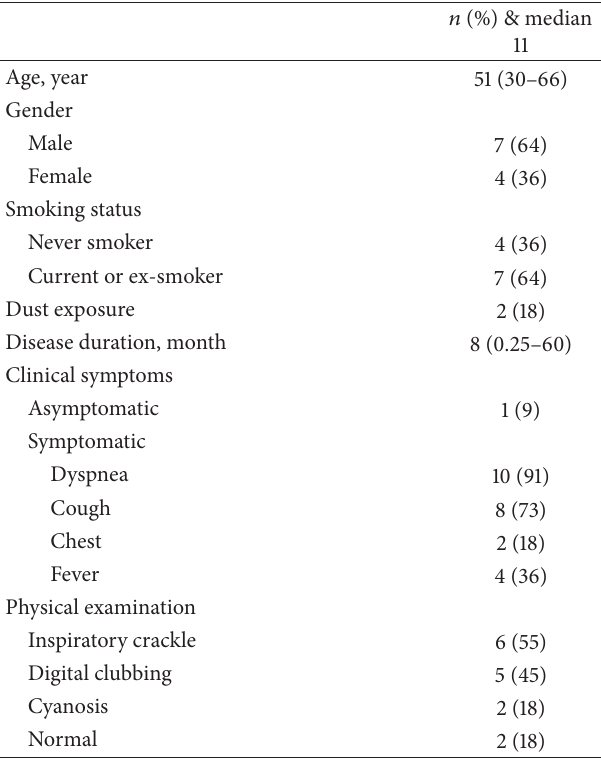
Table 1: Clinical characteristics of PAP